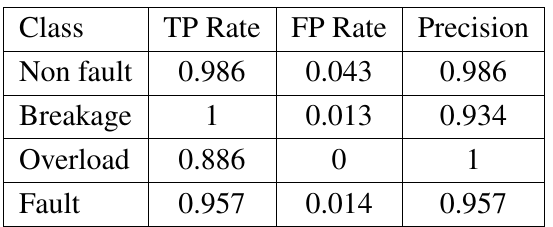
Table 4. Accuracy by class of Bayesian classifier.